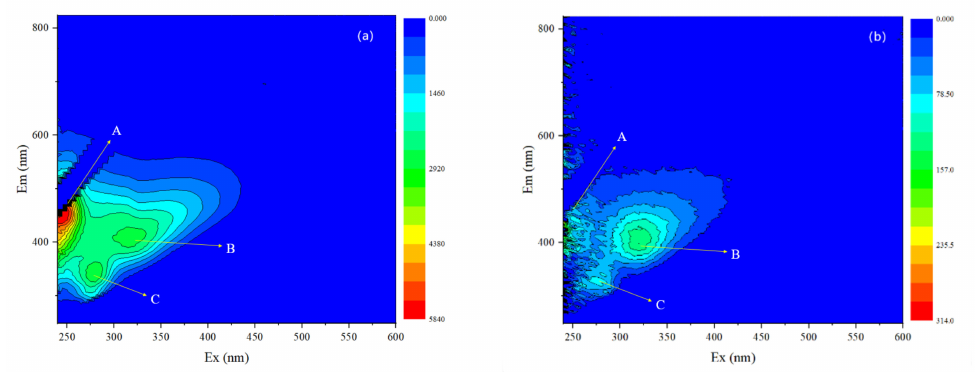
Figure 8. 3D fluorescence spectra of landfill leachate before ( a ) and after ( b ) treatment. (Initial pH: 3.0; PS/12COD ratio: 1; ZVI dosage: 1.5 g/L; current density: 62.5 mA/cm 2 ; reaction time: 6 h).